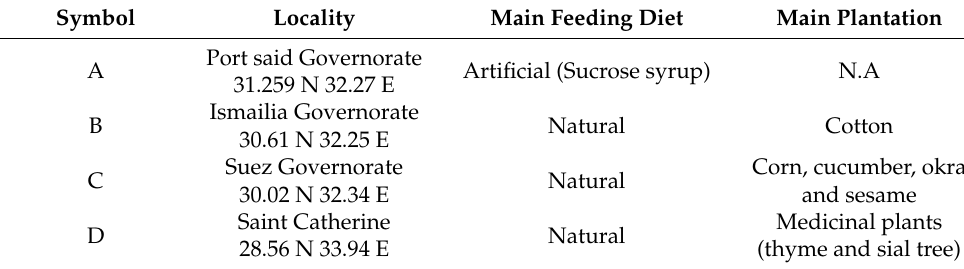
Table 1. Localities, feeding diet and types of plantations in the study areas. Symbol